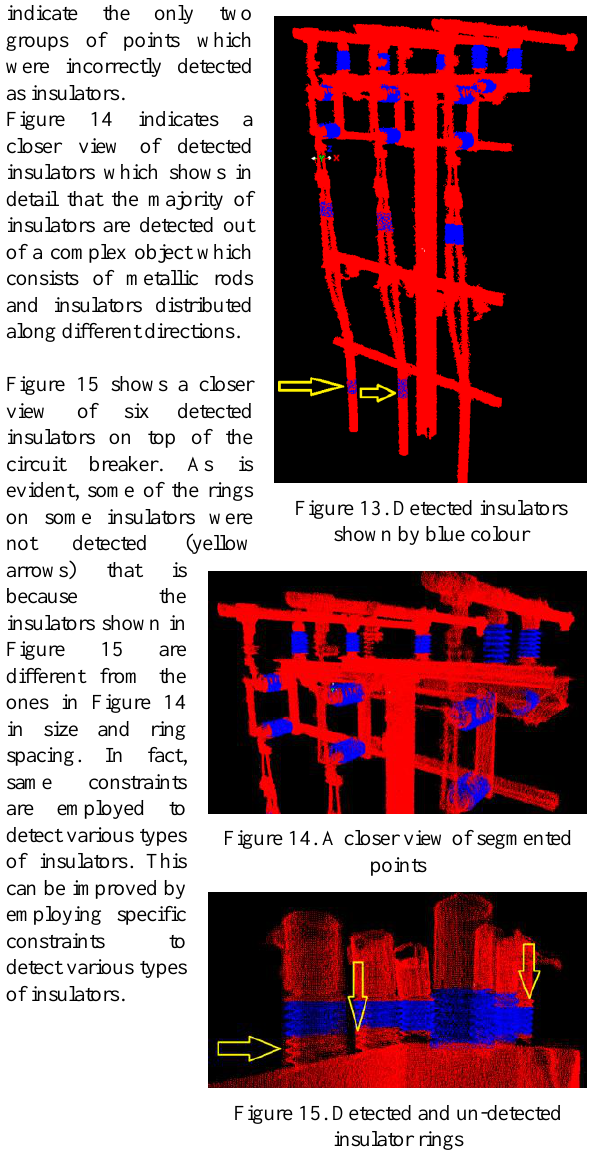
Figure 15. Detected and un-detected